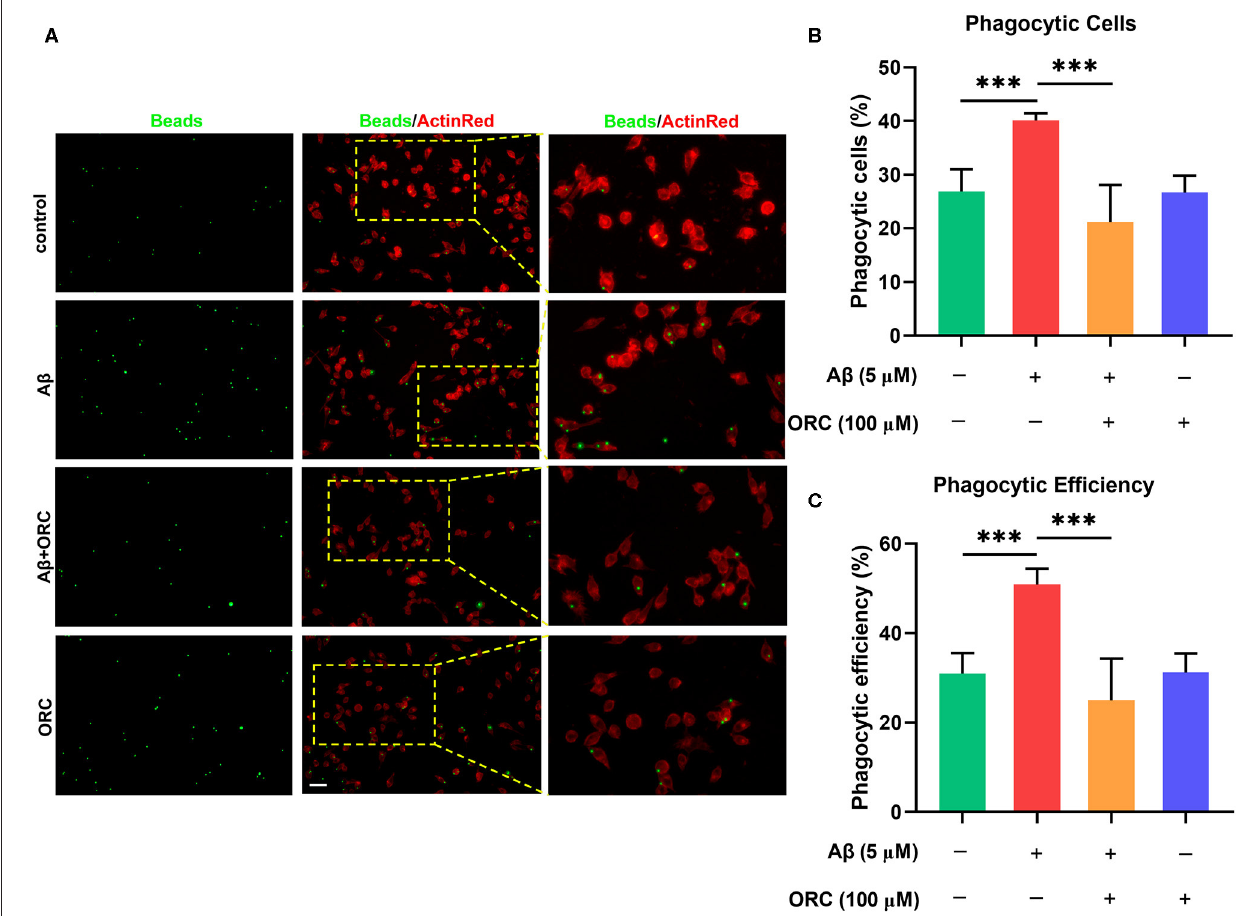
FIGURE 3 | Inhibitory effects of oxiracetam (ORC) on A β -induced phagocytosis by BV2 microglial cells. (A) Representative immunofluorescence images of latex beads phagocytosed by ActinRed-marked BV2 cells. Scale bar: 50 µ m. (B) Quantitative analysis of the percentage of phagocytic BV2 cells treated with A β and/or ORC. (C) Quantitative analysis of the phagocytic efficiency of BV2 cells based on a weighted average of ingested beads per cell. Data represent the mean ± standard deviation ( n = 6 for all groups). *** p < 0.001.